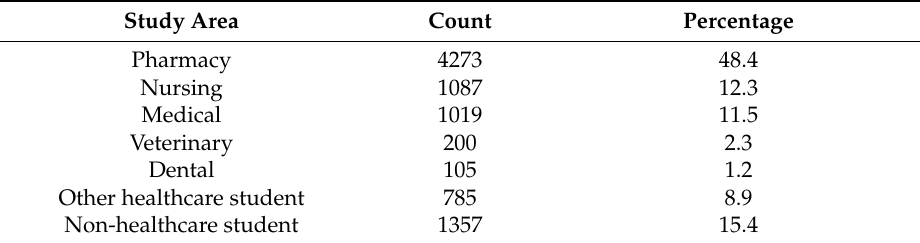
Table 4. Breakdown of student Antibiotic Guardians by study area from 2014–2017 (n = 8826).